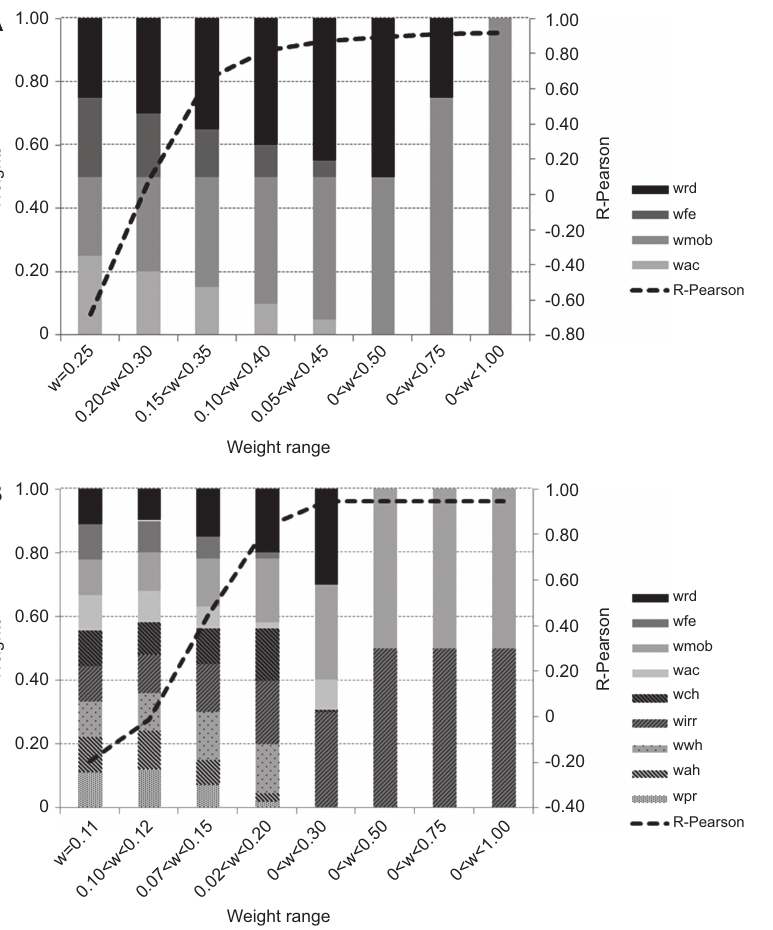
Figure 4 Agreement between the ISI and the EHS methods according to Pearson’s correlation coefficient (R-Pearson) for the assessment results of the decomposed bioethanol production processes based on the three different